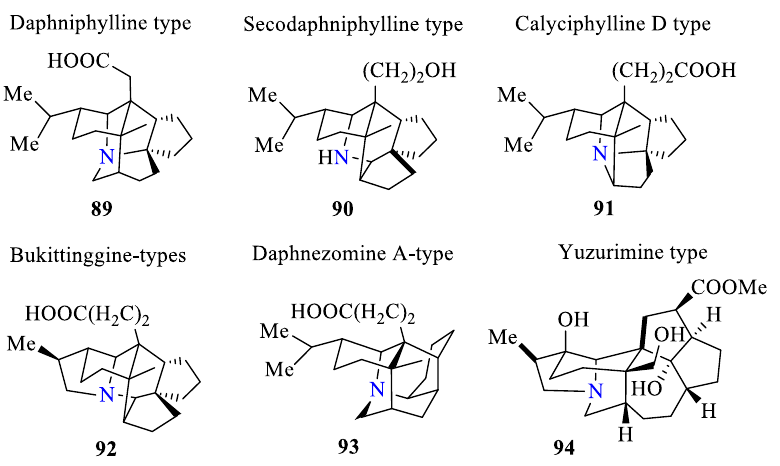
Figure 3. The examples of Daphniphyllum alkaloids.